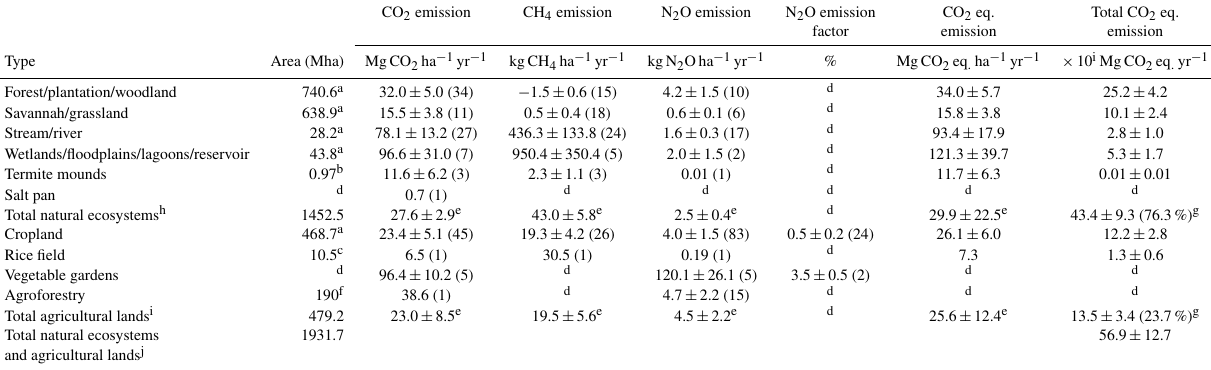
Table 1. Summary of greenhouse gas carbon dioxide (CO 2 ) , methane (CH 4 ) , nitrous oxide (N 2 O), emissions and CO 2 equivalents (CO 2 eq.) in natural ecosystems and agricultural lands in sub-Saharan African countries. Mean ± standard error (number of data) are shown.